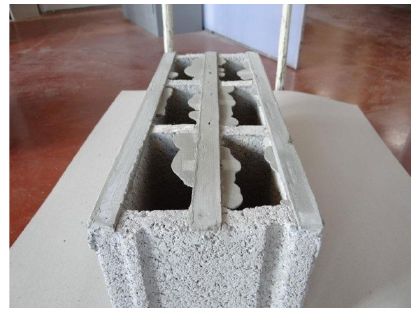
Fig. 4. Capping of masonry elements to be strip bedded